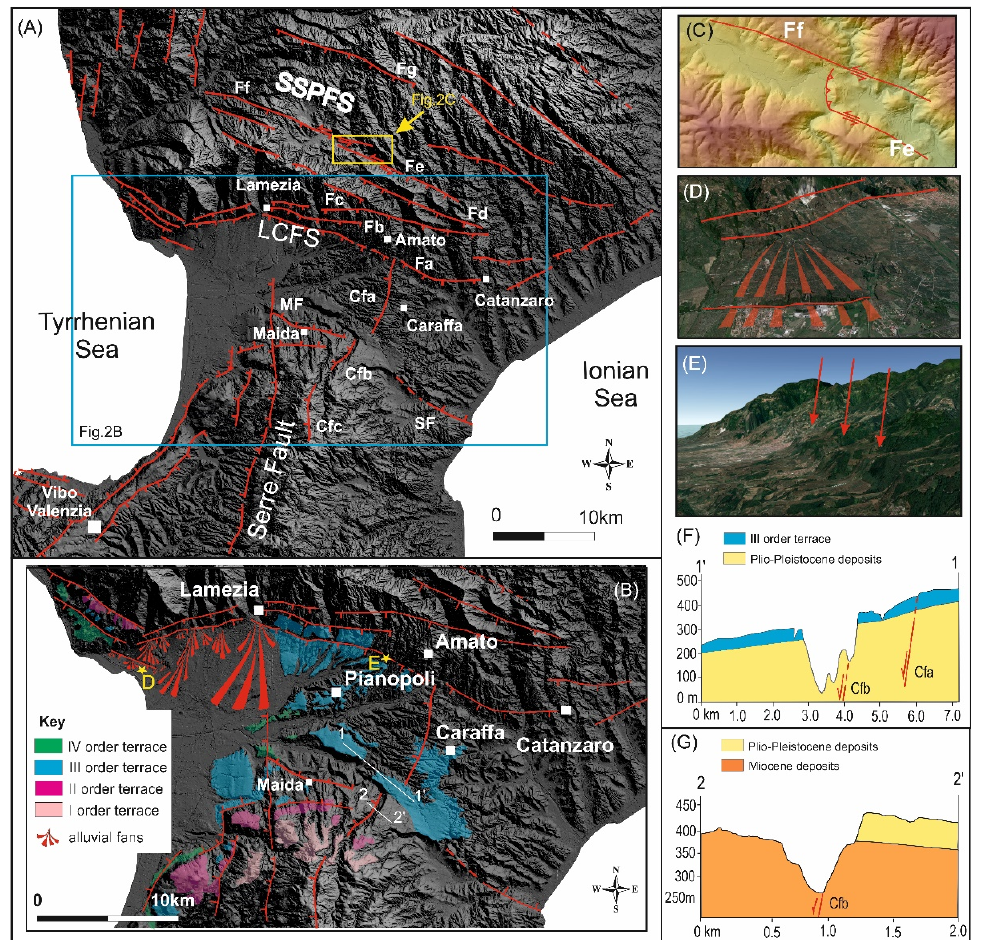
Figure 2. ( A ) DTM hillshade and fault pattern of the Catanzaro Trough area. SSPFS, South Sila Piccola Fault System; LCFS, Lamezia–Catanzaro Fault System; MF, Maida, Fault; SF, Stalettì Fault. Cfa, Cfb, and Cfc are the segments of the Caraffa Fault System. ( B ) DTM hillshade (see Figure 2A for location) showing alluvial fans, faults (dashed where inferred), and colour-coded upper Middle– Upper Pleistocene terraces (modified from Brutto et al. [8] and Gullà et al. [12]); stars indicate the location of Figure 2D,E. ( C ) Push-up ridge between Fe and Ff at the Serrastretta locality (see Figure 2A for location). ( D ) Displaced alluvial fan (see Figure 2B for location). ( E ) Trapezoidal facets created by Fa north of Pianopoli (see Figure 2B for location). ( F ) Schematic geological profile showing the III order terrace warped and tilted by the Cfa and Cfb faults. ( G ) Schematic geological profile showing the Cfb fault scarp and the asymmetric valley.